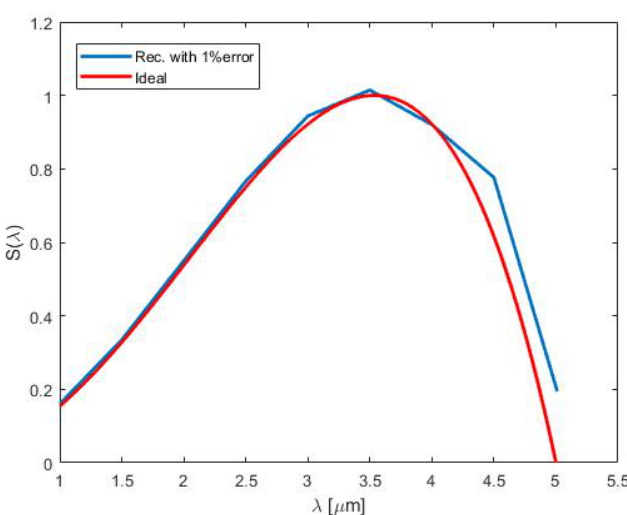
Figure A8. Reconstruction of the spectral response function with Sinc functions compared to the 1% voltage error case.